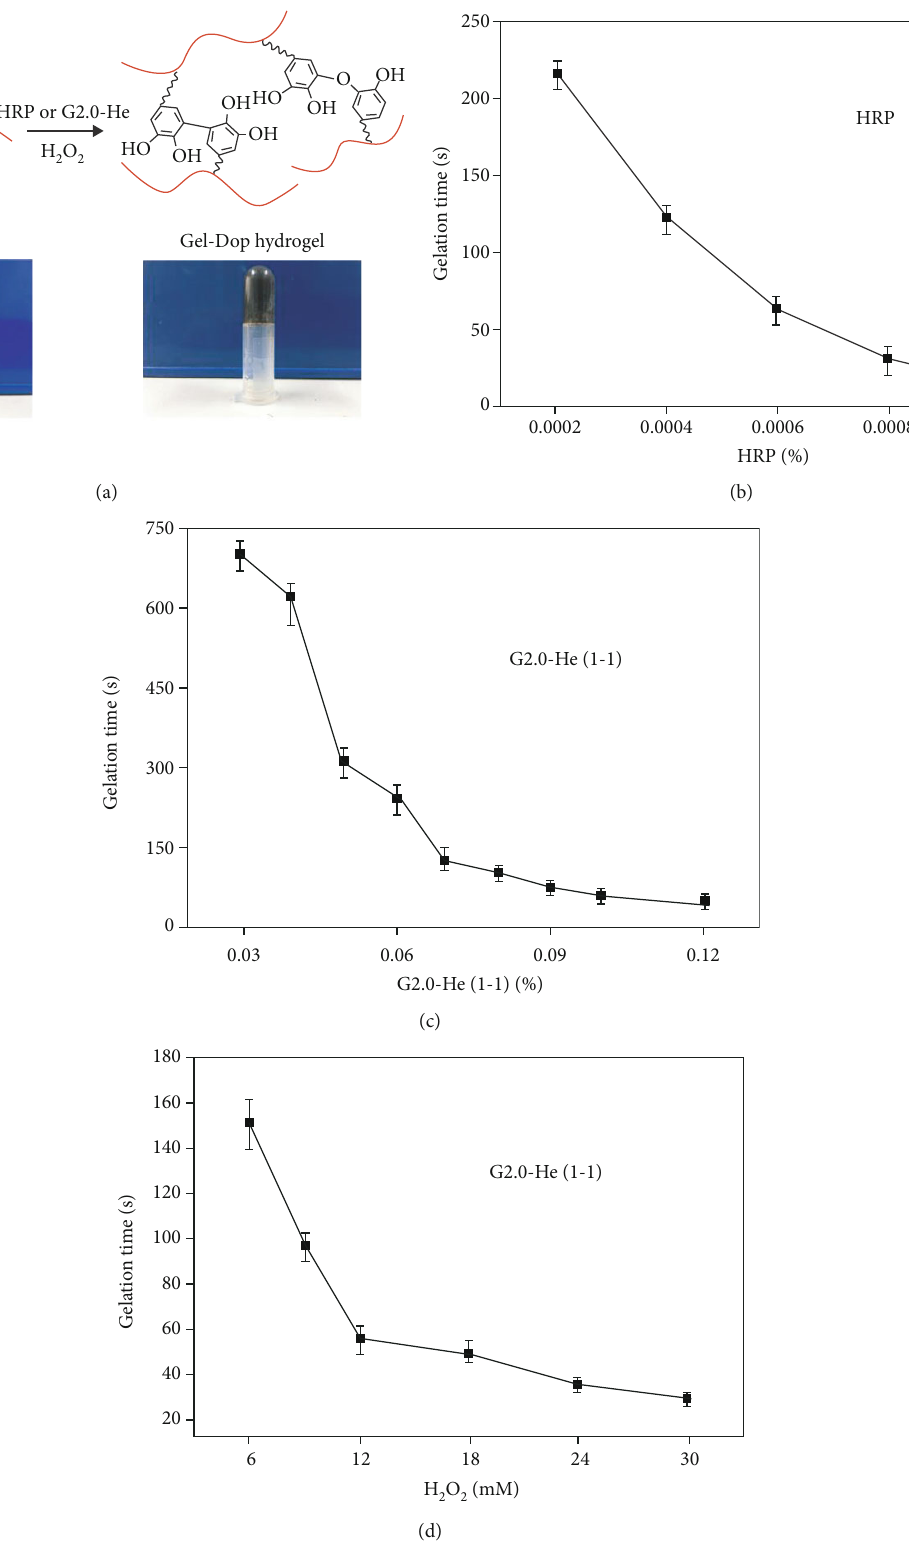
Figure 6: Schematic illustration of Gel-Dop hydrogel formation and photographs of the Gel-Dop/G2.0-He solution before and after gelation (a). The gelation time for forming Gel-Dop hydrogels catalyzed by HRP in the function of enzyme concentration (b) and by G2.0-He (1-1) in the change of either G2.0-He (c) and H O concentration 2 2